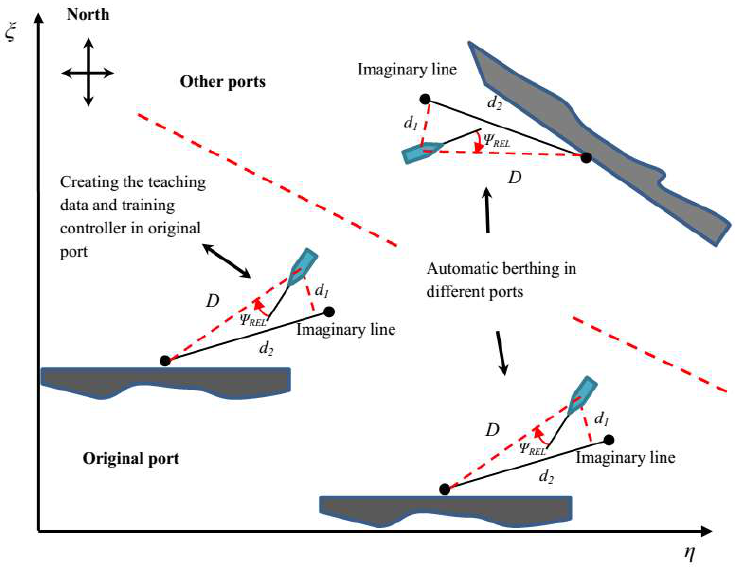
Figure 3. Automatic ship berthing for different ports.